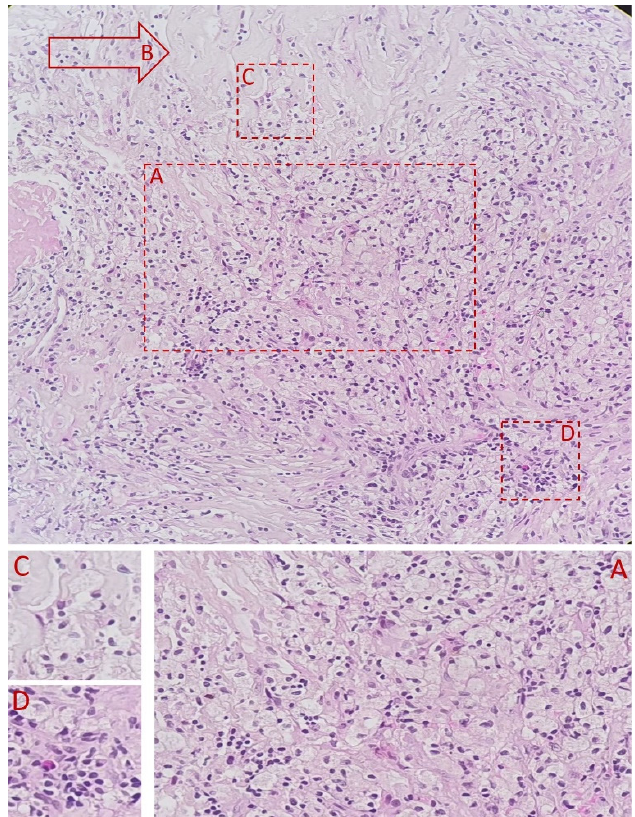
Figure 5. HE stain 40× lens—close-up view of the inflammatory infiltrate. ( A ) highlights the foamy macrophages. ( B ) indicates immature collagen fibers. ( C , D ) note the presence of lympho- plasmacytes .